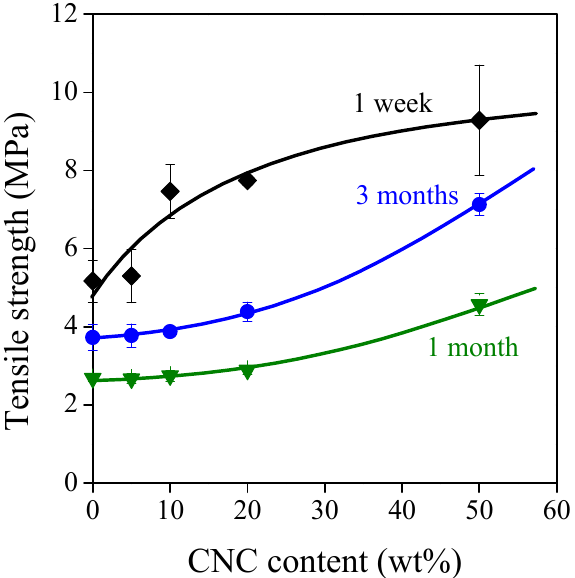
Figure 9. Effect of aging time on the tensile strength of TPS–CNC composites. Plasticizer: 40% glycerol. Symbols: ( (cid:7) ) 1 week; ( (cid:72) ) 1 month; ( • ) 3 months.